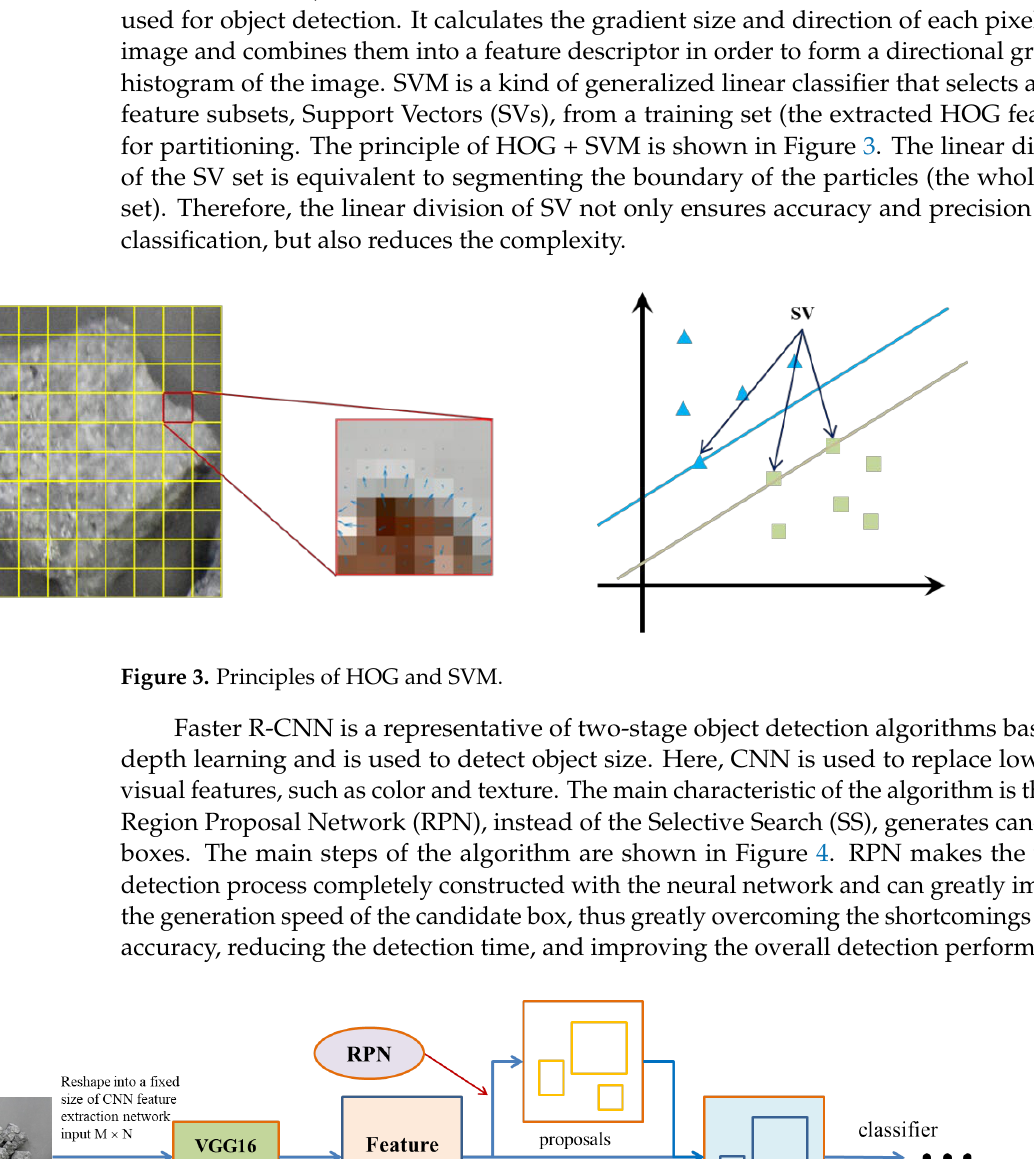
Figure 4. Principle of Faster R-CNN.